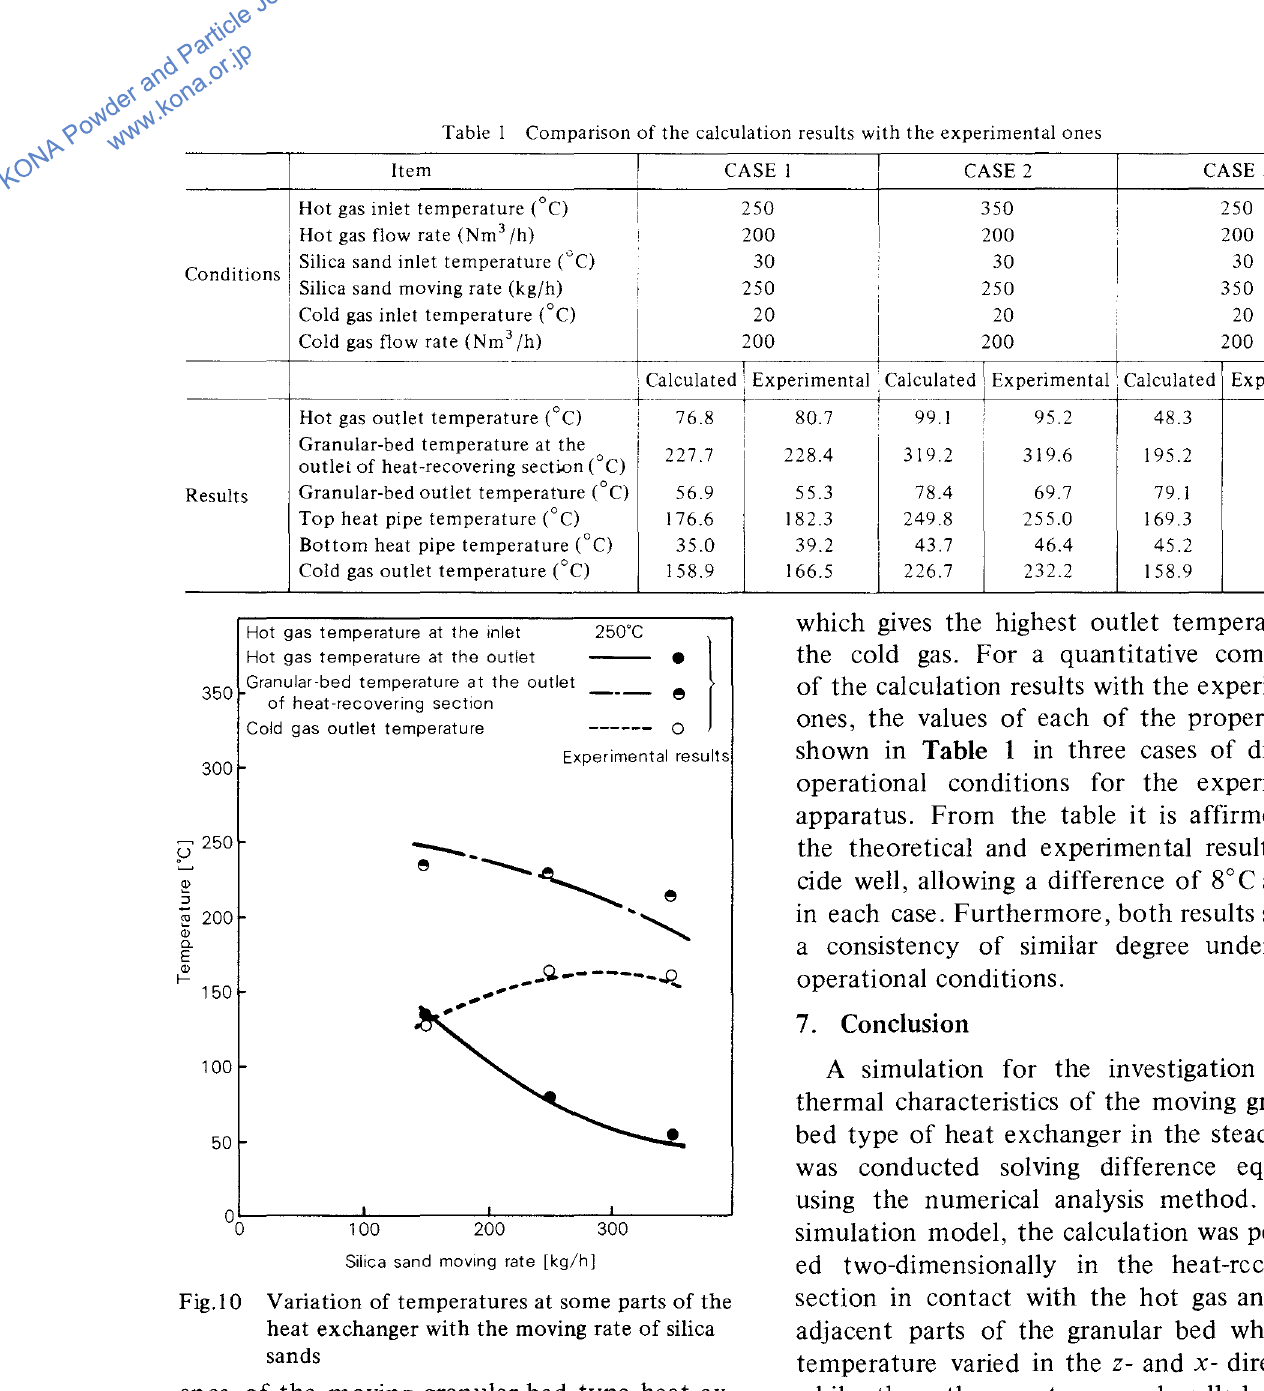
Fig.IO Variation of temperatures at some parts of the heat exchanger with the moving rate of silica